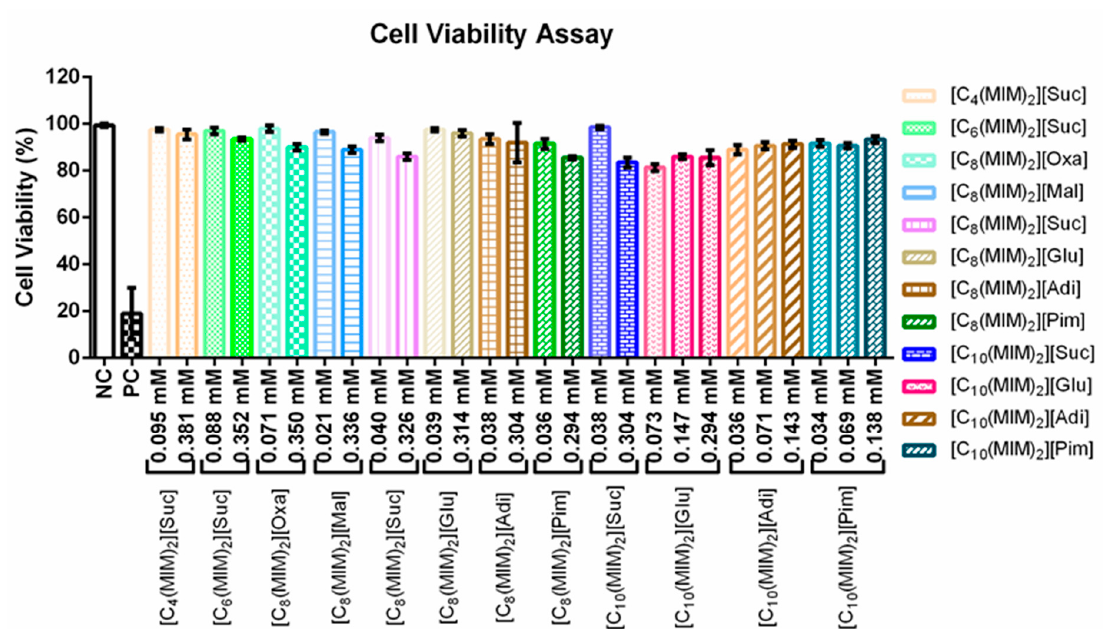
Figure 2. Cell viability evaluated by trypan blue assay after treatment with different concentrations (mM) of the ILs. Values are mean ± SD and indicate statistical differences compared by one-way ANOVA followed by the Tukey post hoc test. The lowercase letters indicate that p < 0.05 when compared to the corresponding control group. The mean values labeled with the same letter are not statistically different from each other.